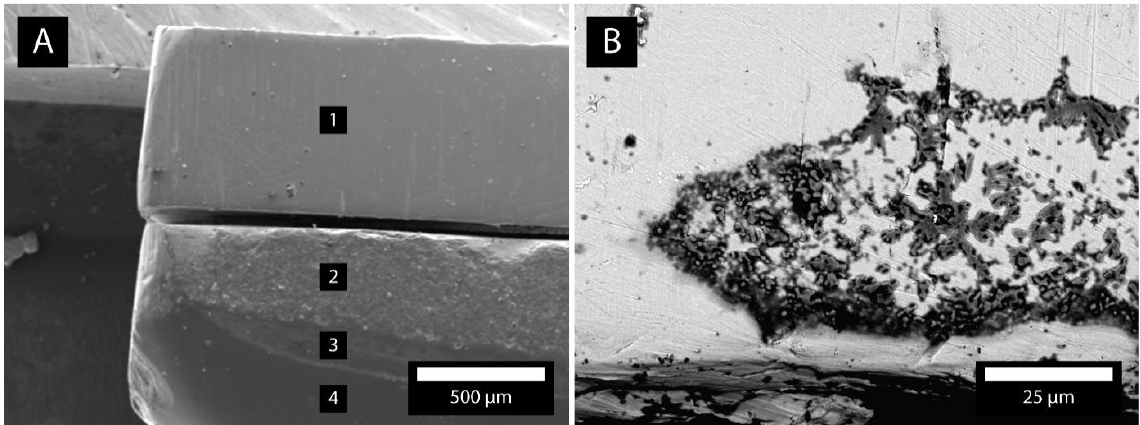
Figure 8. ( A ) Plates composed of Ti (1), Au (2), and the composite (3 and 4). ( B ) Gap between materials 1 and 2 with adhered bacteria.